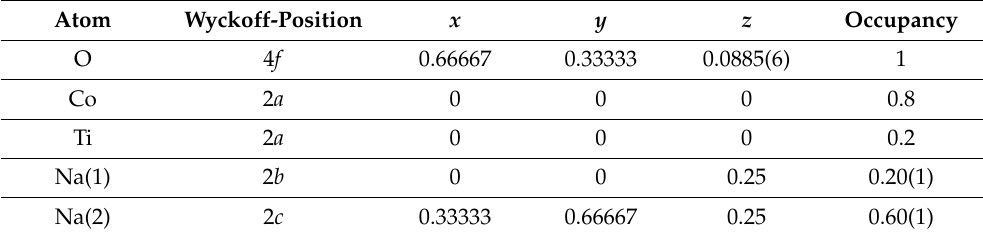
Figure 1. Structural model of Na 0.8 Co 0.8 Ti 0.2 O 2 , measured XRD pattern of Na 0.8 Co 0.8 Ti 0.2 O 2 (red circles) together with the calculated one (black line) and the difference between them; Co K¦Á-radiation. Table 1. Structural model of Na 0.8 Co 0.8 Ti 0.2 O 2.